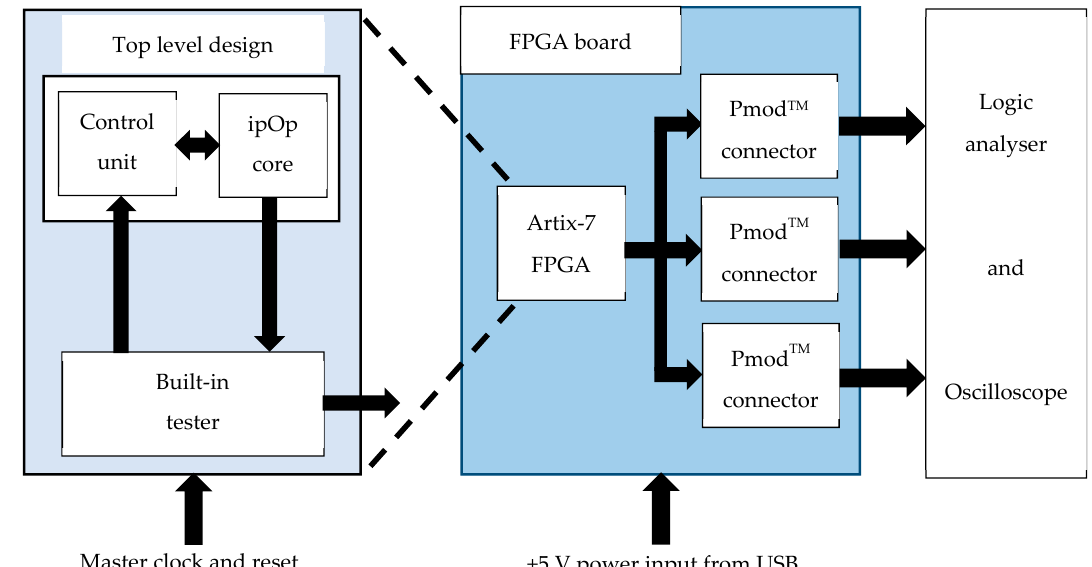
Figure 12. Embedded hardware tester.